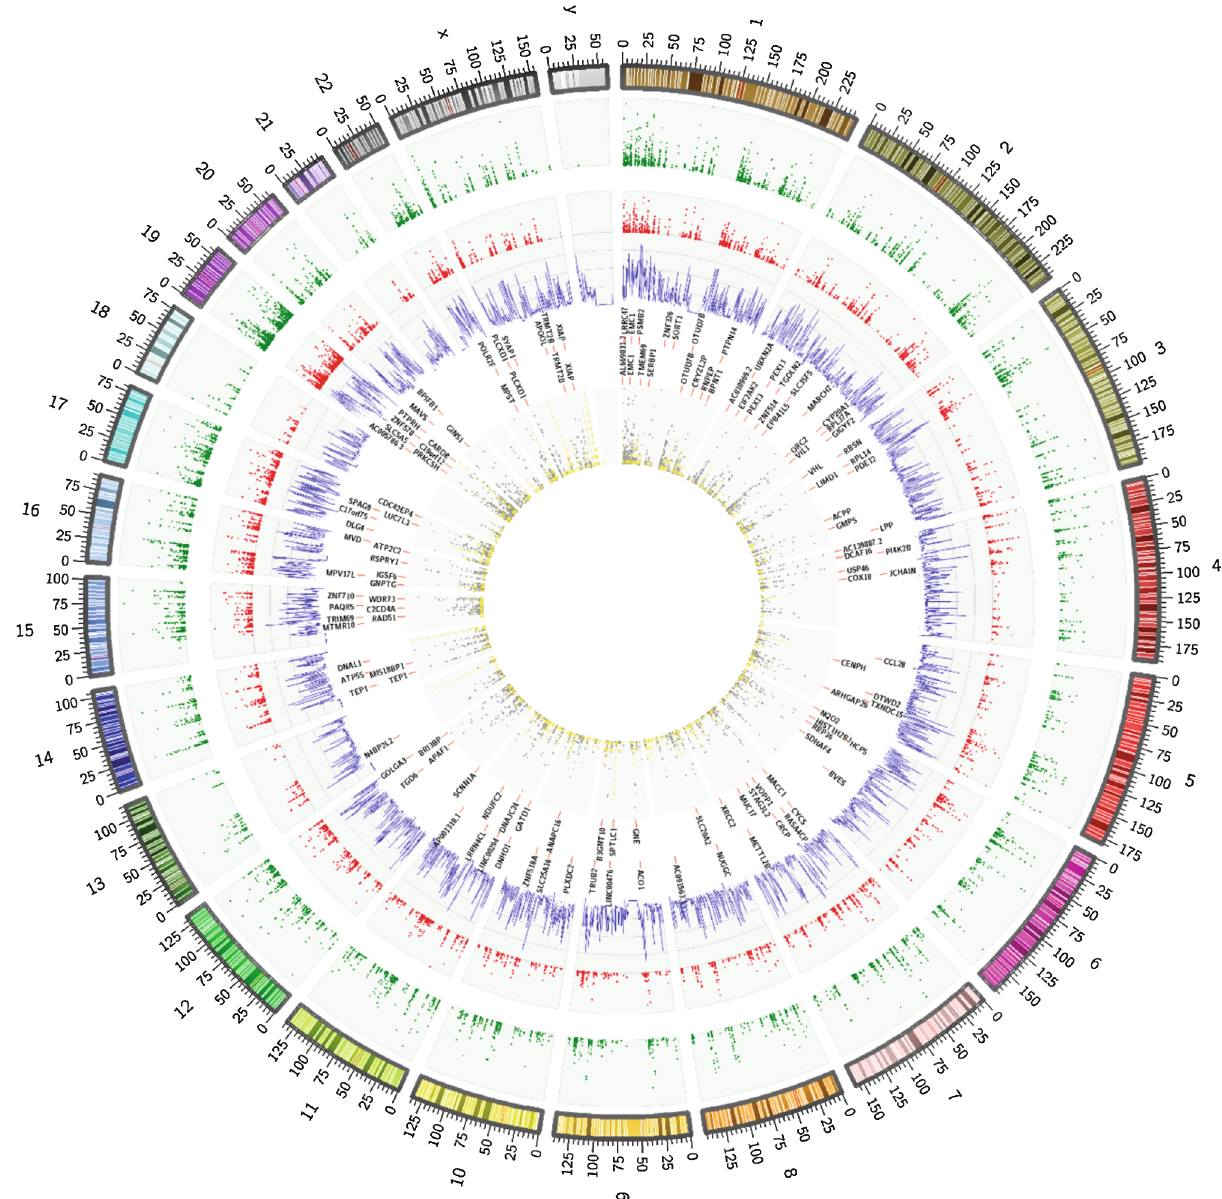
Figure 5: Pro fi ling of RNA editing sites in normal and cancer tissues of gastric cancer patients. The human genome is represented as the outermost ring. Each of normal and cancer tissue editing sites is shown by green and red dots. The purple line plot indicates Alu repeat distribution across the genome. Also, outer and inner text circles indicate normal-speci fi c di ff erentially edited genes and cancer-speci fi c di ff erentially edited genes, respectively. Yellow bars represent microRNA targeting sites in the genome, and grey scatter dots indicate editing sites in these